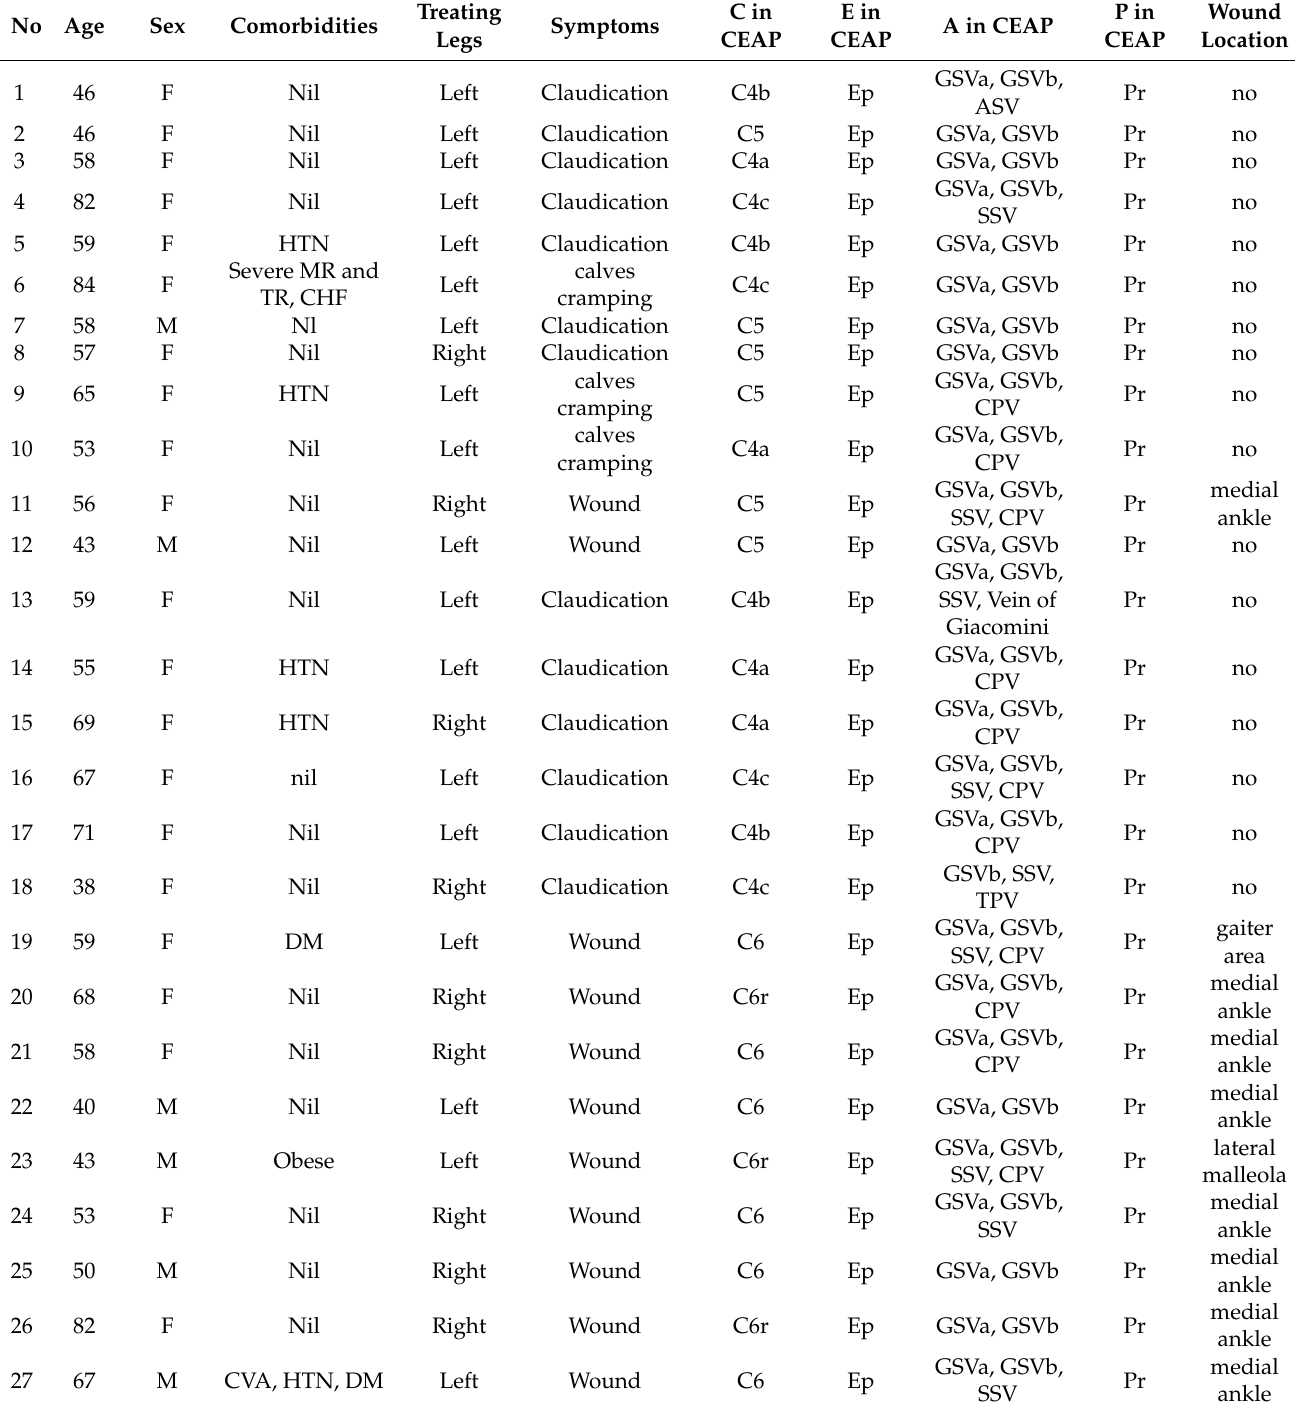
Table 1. Demographic data of the 30 patients with symptomatic varicose vein TRANCE MR as preoperative evaluation. No